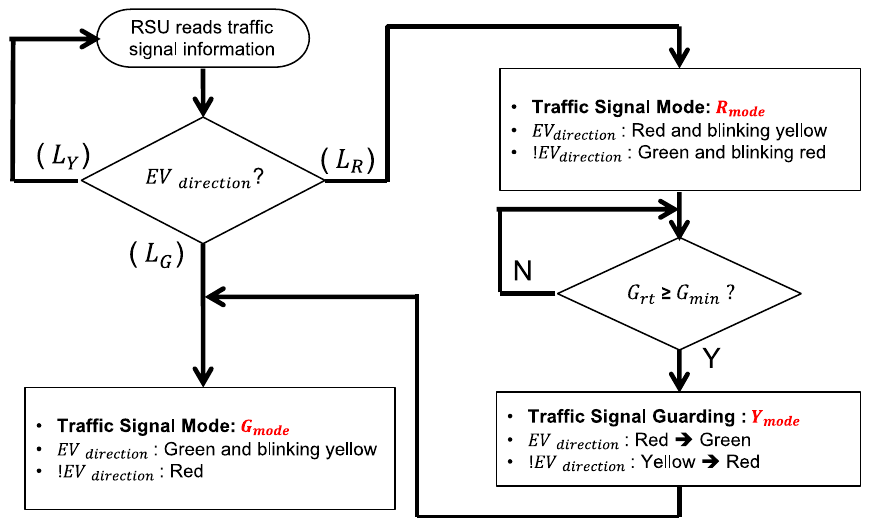
Figure 9. Traffic signal control algorithm. Figure 9. Tra ffi c signal control